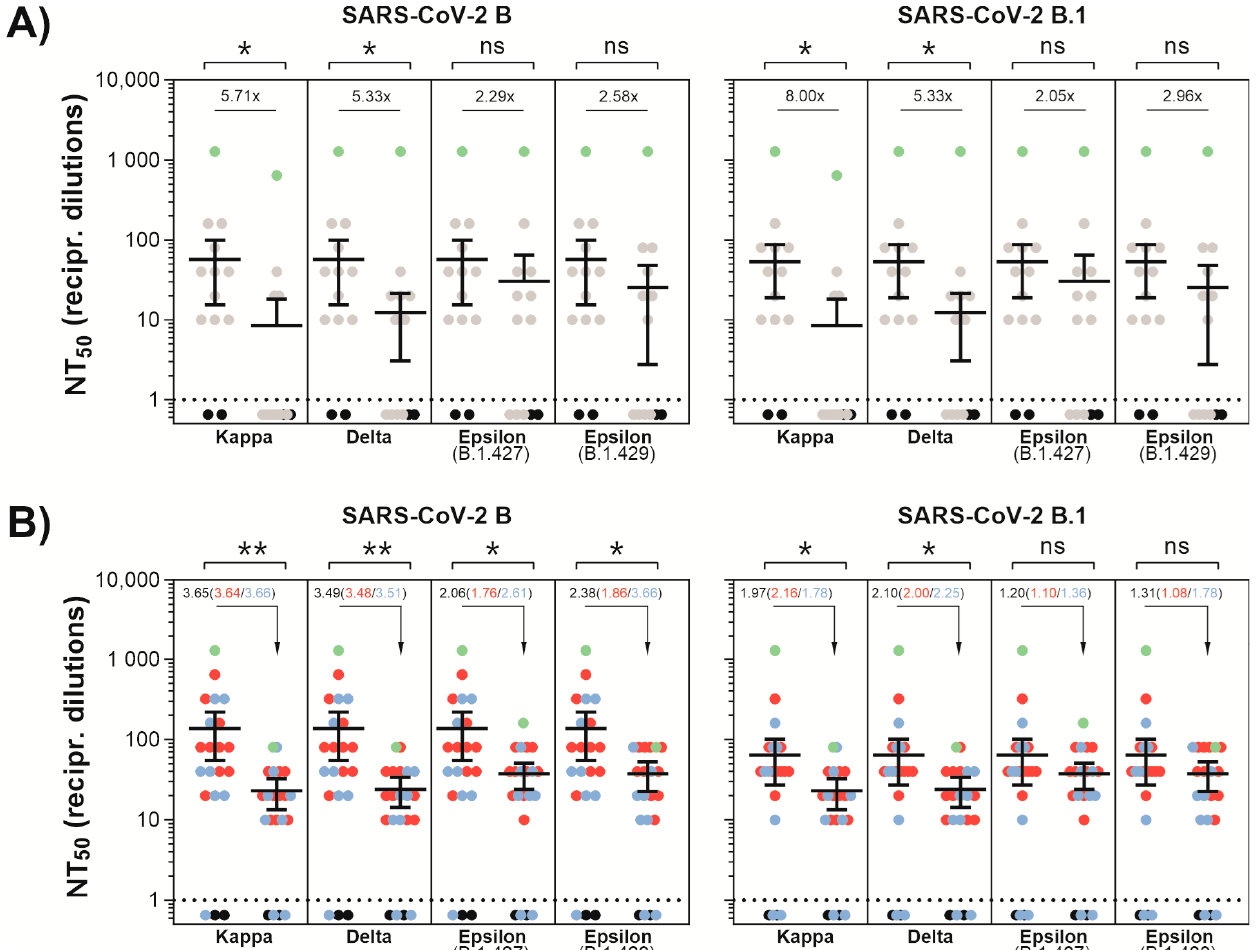
Figure 1. Antibody-mediated neutralization efficacy against SARS-CoV-2 variants. ( A ) A549-AT cells were incubated with serially diluted (1:2) sera from convalescent plasma with the indicated SARS-CoV-2 variant. Dots indicate convalescent sera (grey), negative sera (black), and serum from an immunocompromised individual with a long-lasting SARS-CoV-2 infection (green). ( B ) A549-AT cells were incubated with serially diluted (1:2) sera from vaccinated individuals together with the indicated SARS-CoV-2 variant. Dots specify sera from BNT162b2 (blue), mRNA1273 (red) vaccinated individuals, and negative sera (black). Additionally, serum from a BNT162b2-vaccinated, initially seropositive individual (green) is shown. Statistical significance compared to FFM1 (B) and FFM7 (B.1) was calculated by two-tailed, paired student’s t -tests. Green dots shown in A and B were excluded from significance testing. Mean values ( n = 2) are depicted with 95% confidence intervals. Asterisks indicate p -values as ns ( p > 0.05), * ( p < 0.05) and ** ( p ≤ 0.01).